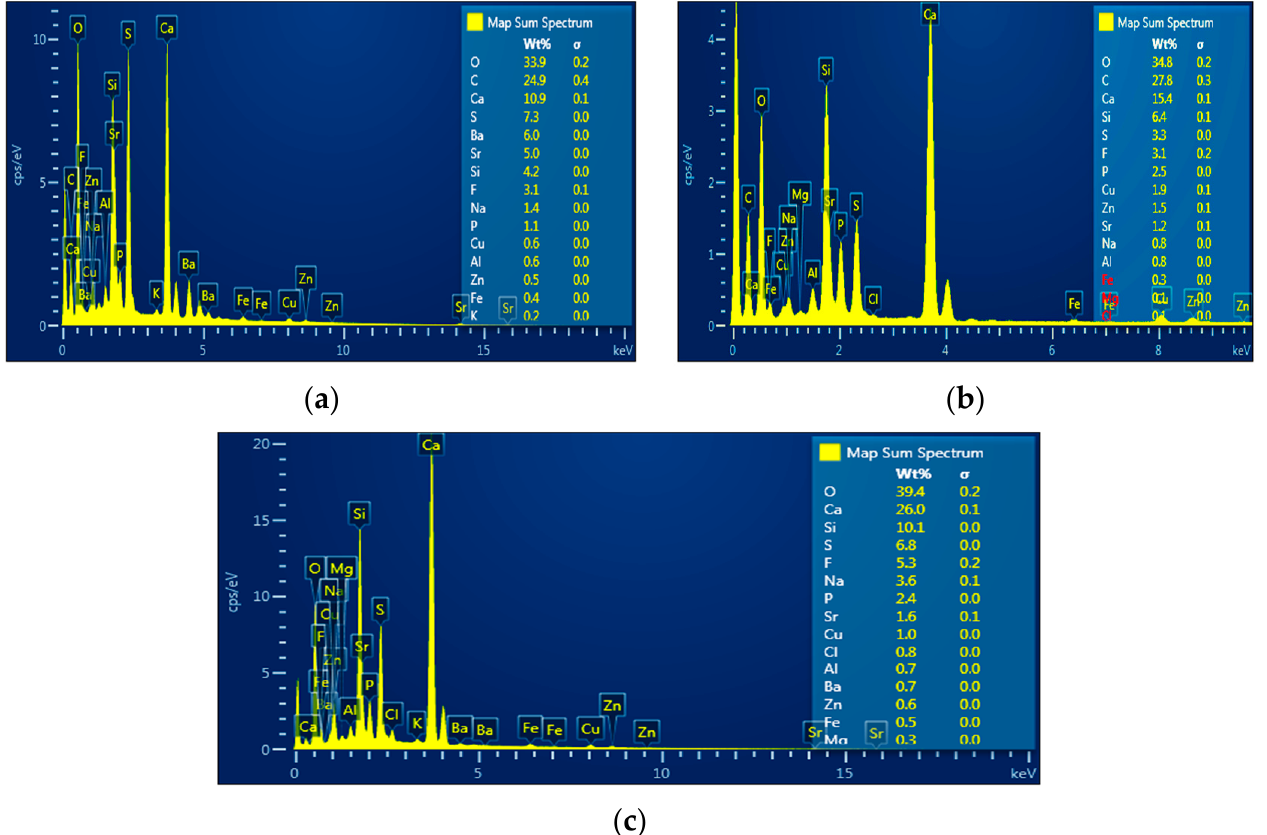
Figure 9. EDS analysis of phosphate waste after 40 min of treatment and with a plasma current of ( a ) 100 A, ( b ) 130 A, and ( c ) 160 A.